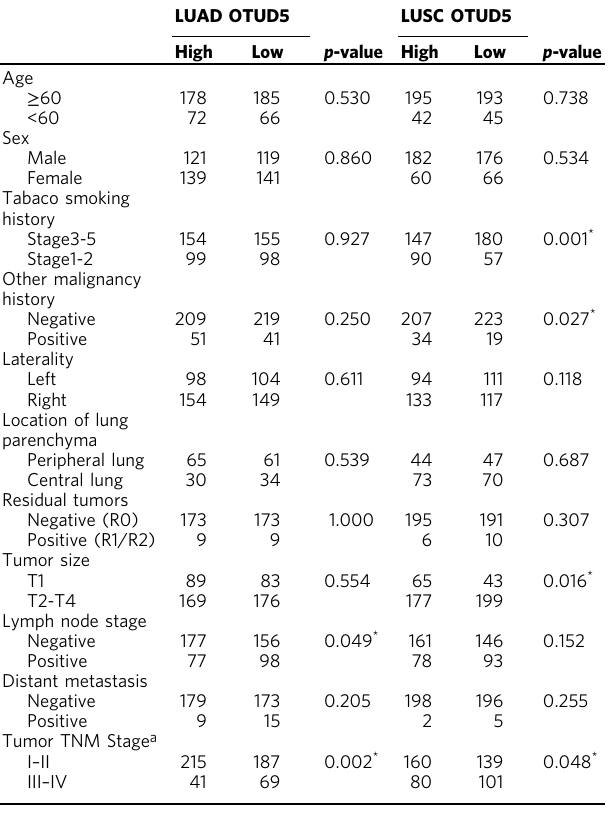
The cutoff value for OTUD5 mRNA expression was set at 10. NSCLC non-small-cell lung carcinoma, LUAD lung adenocarcinoma, LUSC lung squamous cell carcinoma. a Tumor TNM stage was strati fi ed as I-IIA and IIB-IV for the LUSC patients. The Chi-square test was performed to analyze the relationship between OTUD5 expression level and demographic and clinical pathological parameters. All p- values were two sided and the level of statistical signi fi cance was set at<0.05. * p collected for fl ow cytometric analysis. The full-length complementary DNA (cDNA) and deletion/point mutation mutants of human OTUD5 were generated by PCR and subcloned into a pCIN4-Flag or pCIN4-HA vector. cDNA or various fragments of the human TRIM25 gene were cloned into a pRK5-Flag or pCIN4-HA vector for expression. RNA interference . Stable OTUD5- and TRIM25- knockdown cells were generated by infection with lentivirus-based shRNAs. The lentiviral vector (pLVX-shRNA2, Clontech) containing either shRNAs targeting the indicated genes or a negative control of a scrambled sequence was transfected into 293T cells along with psPAX2 and pMD2.G plasmids to produce the lentivirus. The virus containing medium was collected, supplemented with 8 μ gml − 1 of polybrene (Sigma), and incubated with